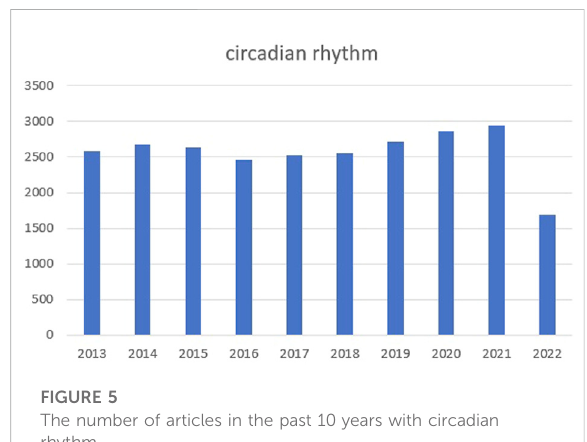
FIGURE 5 The number of articles in the past 10 years with circadian